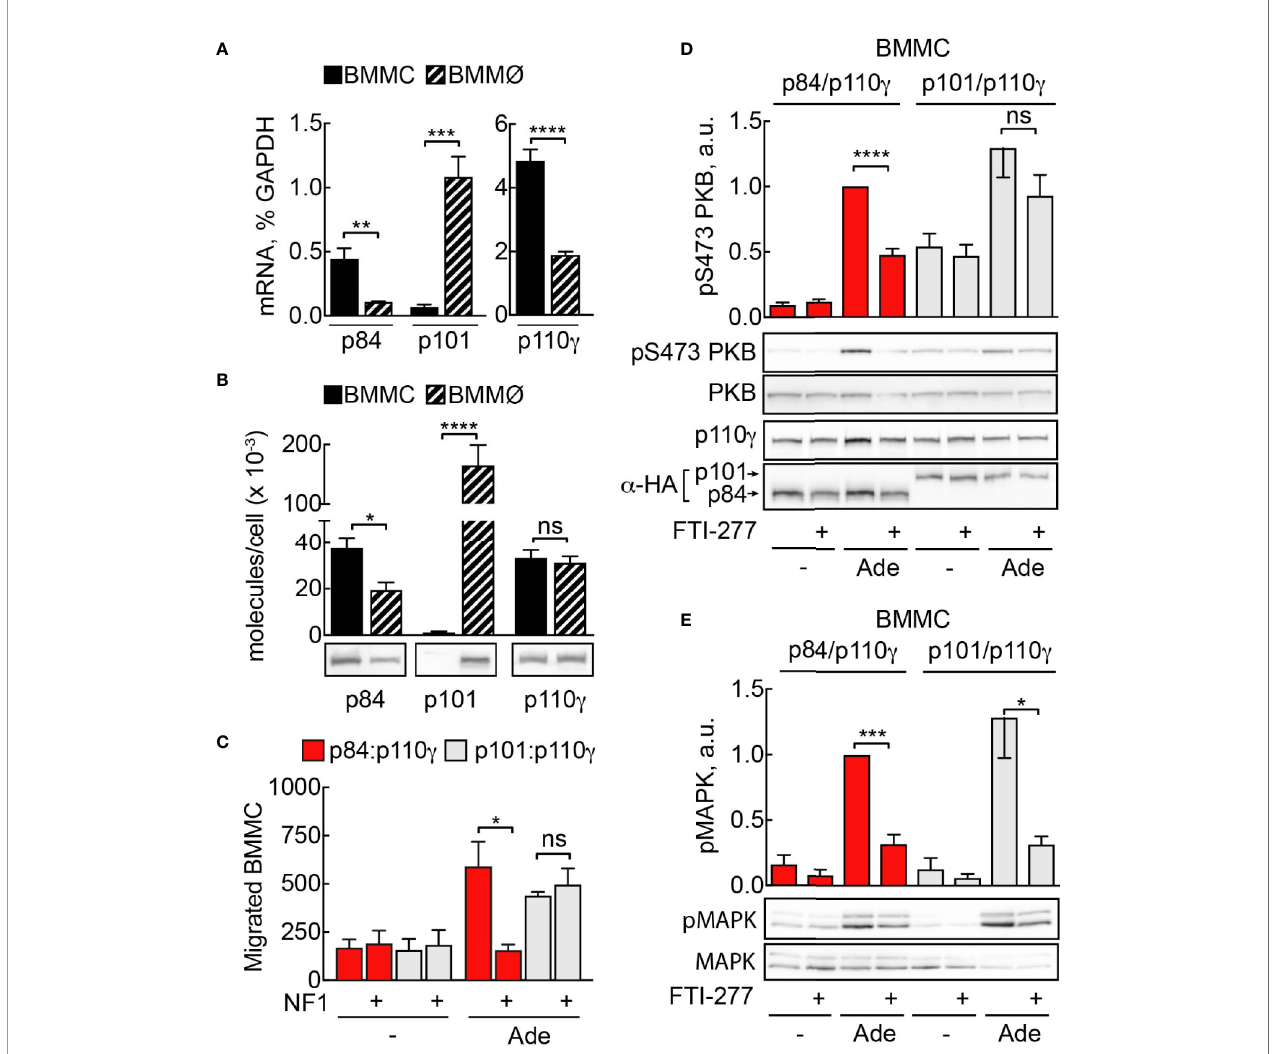
FIGURE 8 | Sensitivity to Ras inhibition is de fi ned by PI3K g adaptor subunit. (A) Expression of p110 g , p84, and p101 in BMMCs and BMMØs was assessed by qPCR and normalized to GAPDH expression in BMMCs. (B) p84, p101, and p110 g proteins were detected in BMMC and BMMØ lysates by Western blotting and quanti fi ed using recombinant p84/p110 g and p101/p110 g complexes with known protein concentration. (C) p110 g and HA-p84 or HA-p101 were co-expressed with or without Flag-NF1 (GAP domain) in p110 g − / − BMMCs; additionally, GFP-expressing plasmid was used to select for transfected cells. Migration of GFP-positive BMMCs was assayed in Transwell chambers for 6 h in the presence of 2 µM Ade in the lower well. Subsequently, GFP-positive cells were quanti fi ed by fl uorescence microscopy. The panel contains n = 5 biological replicates from two independent experiments. (D, E) p110 g − / − BMMCs were transfected with plasmids encoding functional p110 g and either HA-tagged p84 or p101. 5 h after transfection cells were put in fresh medium containing DMSO or 5 µM FTI-277. The next day, cells were starved in IL-3-free medium containing 2% FCS and stimulated with 2 µM Ade for 2 min at 37°C. Phosphorylation of PKB at Ser473 and MAPK was determined by Western blotting and normalized to the total PKB or MAPK levels, correspondingly. Transient expression of p110 g was assessed with anti-p110 g antibodies, while p84 and p101 were detected with anti-HA antibodies (n = 5 – 6). Student ’ s t-test was performed to test for statistical